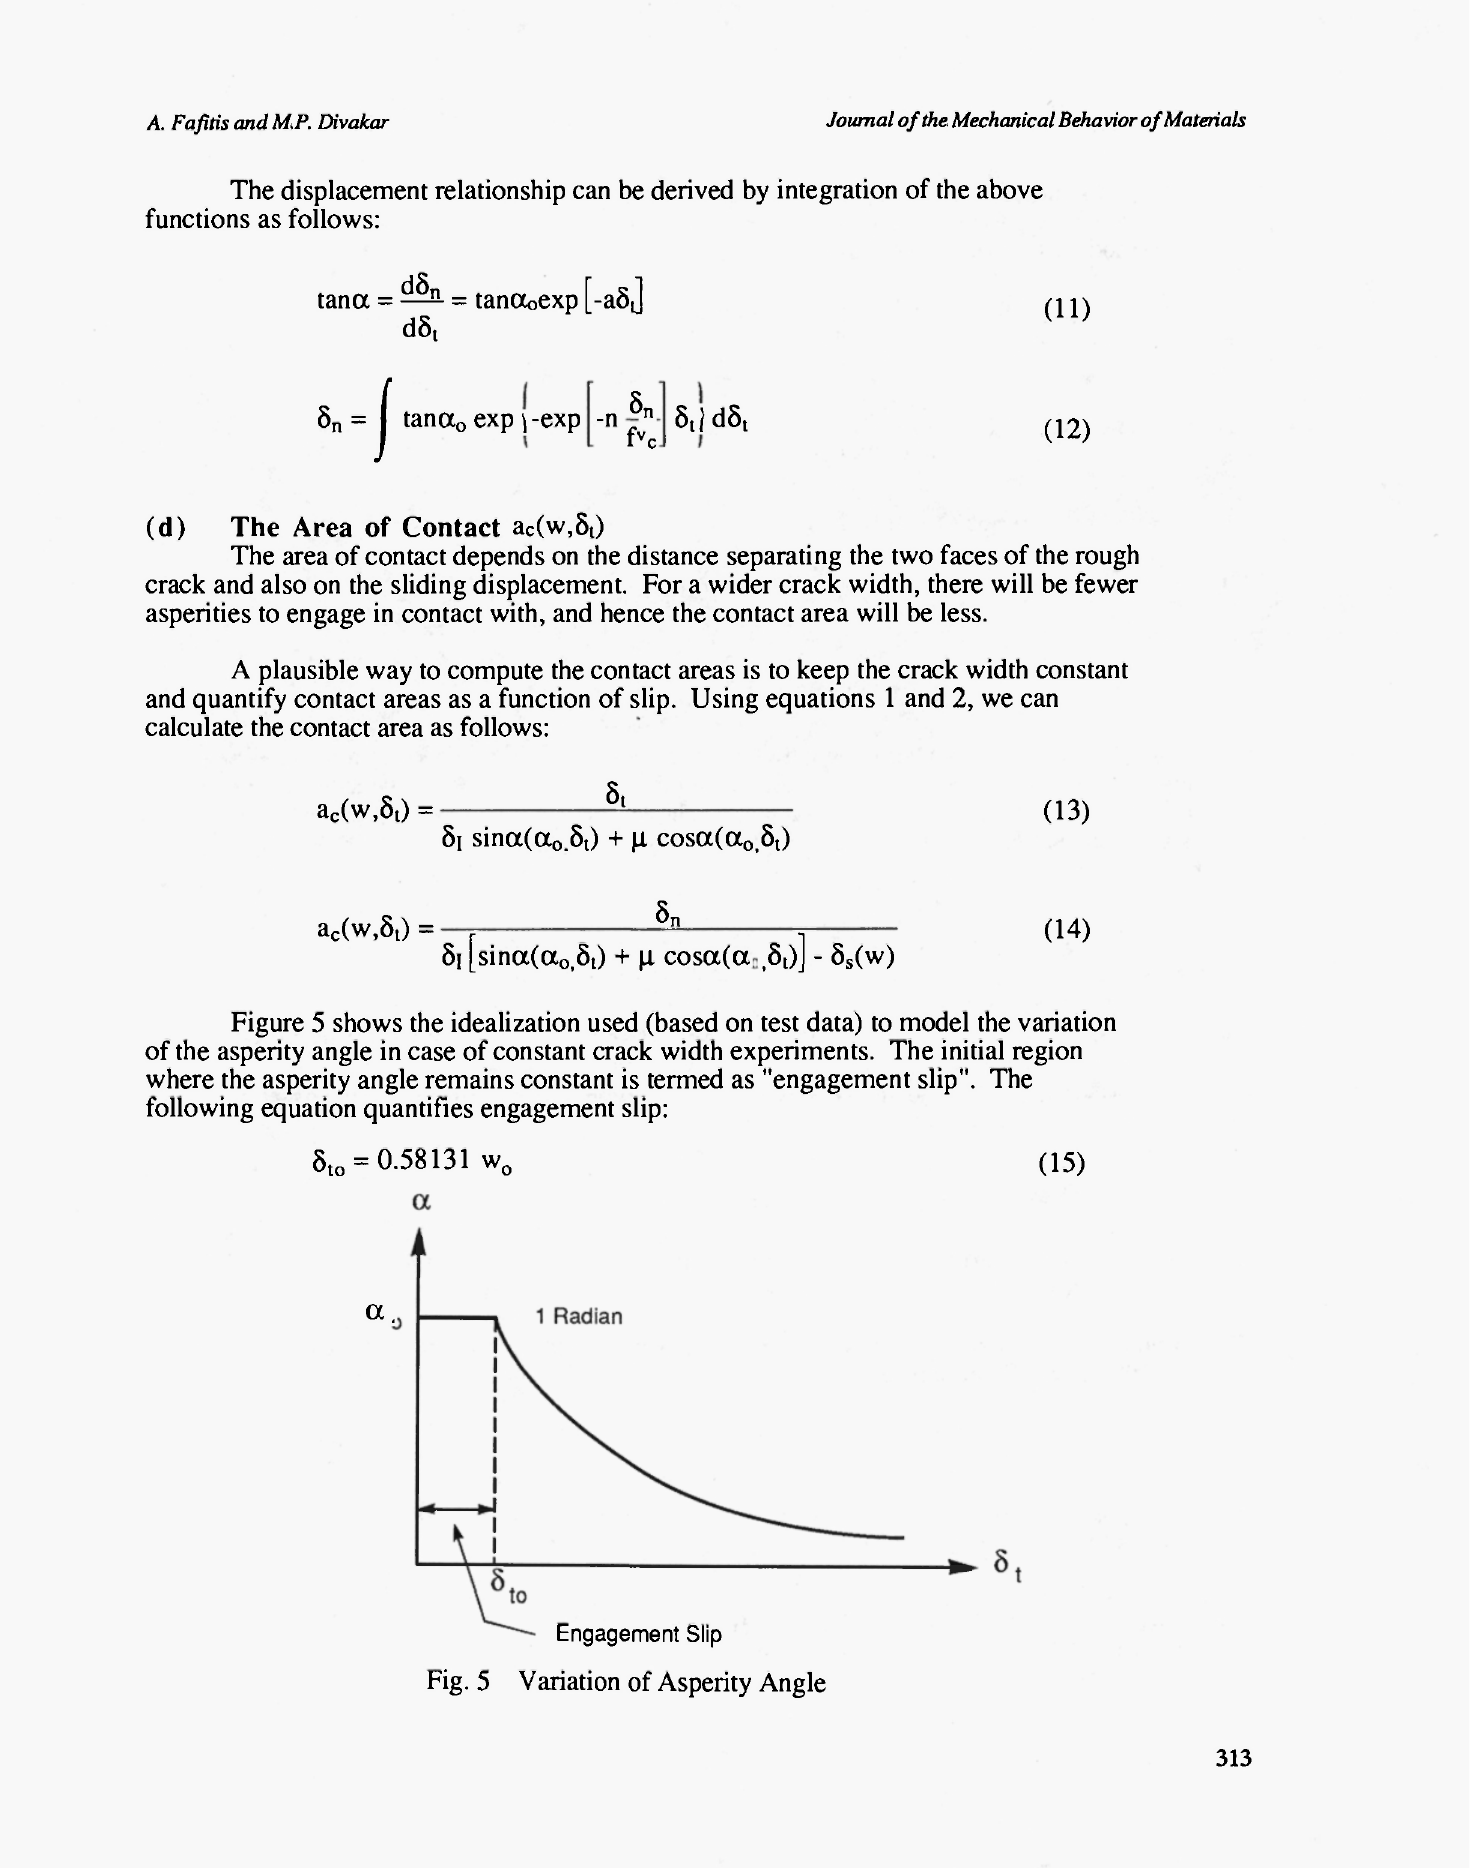
Fig. 5 Variation of Asperity